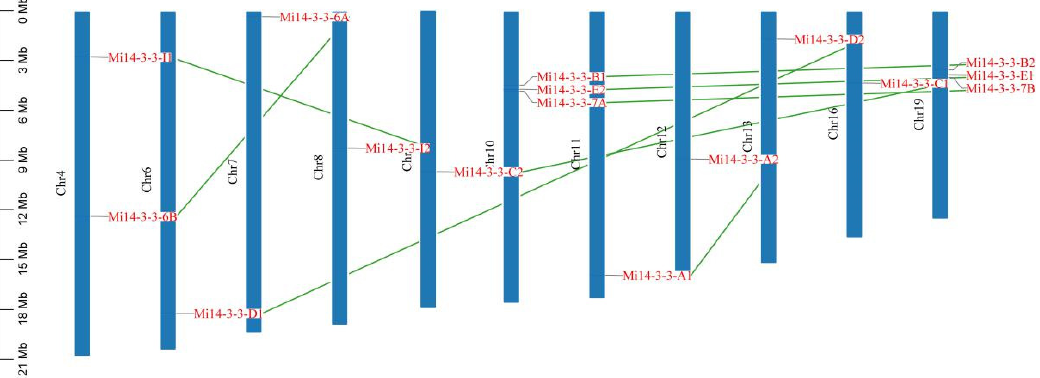
Figure 4. Genomic distribution of 14-3-3 ( Mi14-3-3 ) genes across the eleven mango chromosomes. The list of organisms by chromosome count is shown on the upper-left side of each chromosome. The scale is in megabases (Mb). The chromosomal locations of the Mi14-3-3s were determined according to the physical location of each gene.